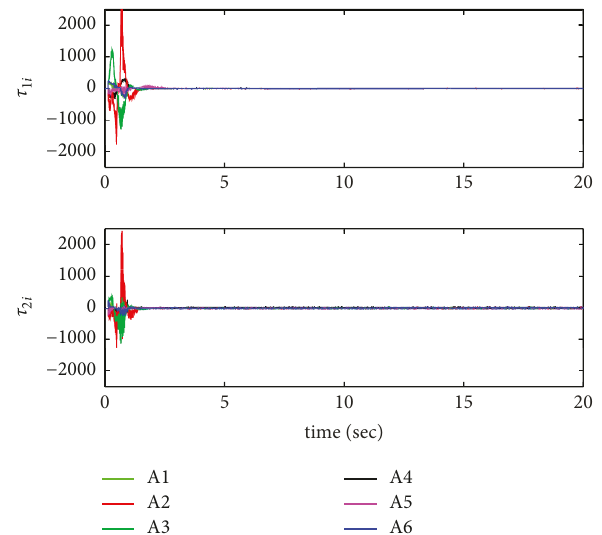
Figure 15: The control inputs τ (AFSFC).